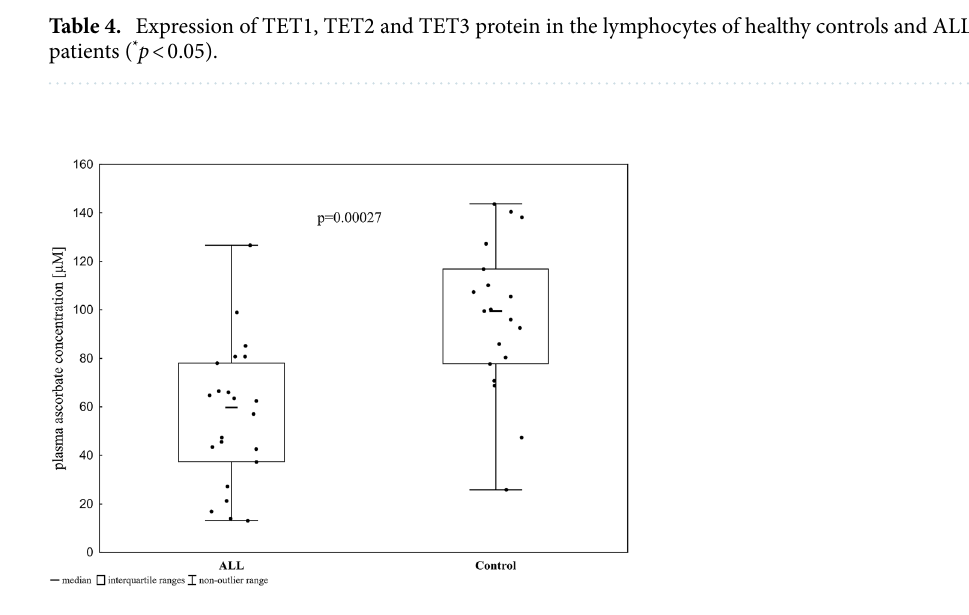
Figure 5. Ascorbic acid in